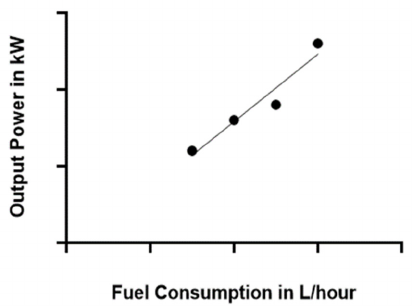
Figure 2. C65 microturbine fuel curve input-output characteristics .